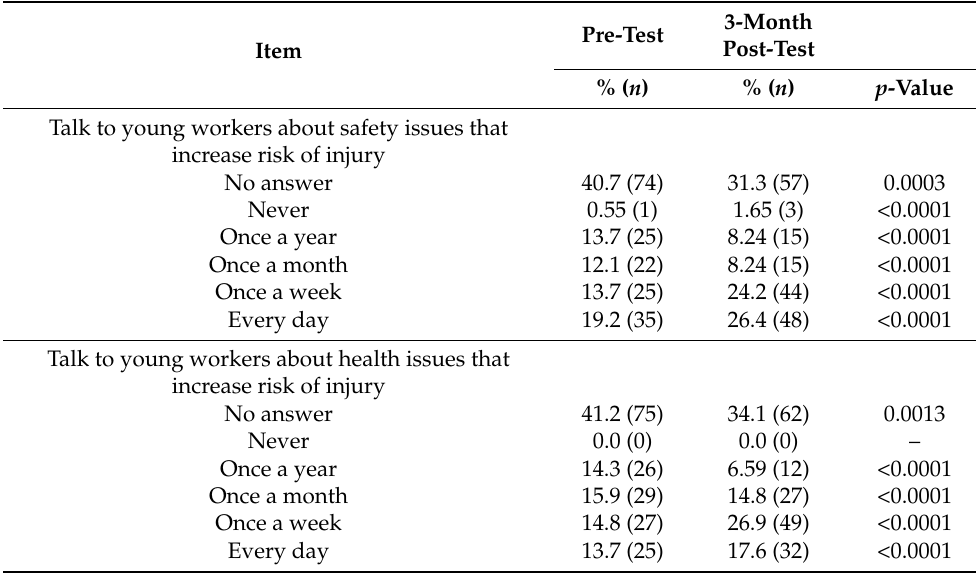
Table 7. Changes in supervisors’ frequency of how often they talk to young workers about safety and health issues that impact their risk of injury ( n = 182).